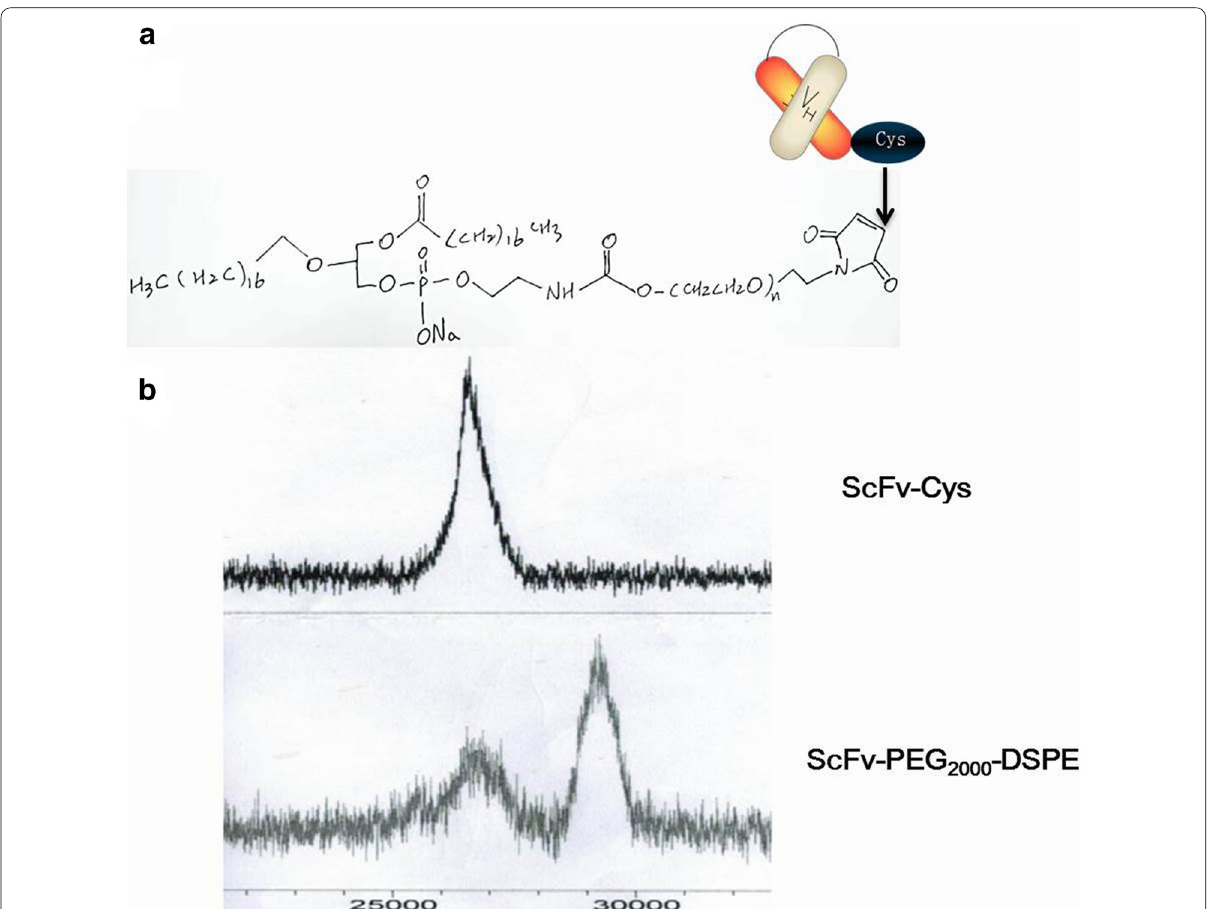
Fig. 4 Analysis of ScFv-PEG2000-DSPE by MALDI-TOF–MS. a The coupling schematic of PEG2000-DSPE and ScFv-Cys. b The purified product of DSPE-PEG2000-ScFv was verified by MALDI-TOF MS. The theoretical molecular weight (MW) of malDSPE-PEG2000 is 3 kDa, so the experimental MW of ScFv and DSPE-PEG2000-ScFv were exactly 26 kDa and 29 kDa,